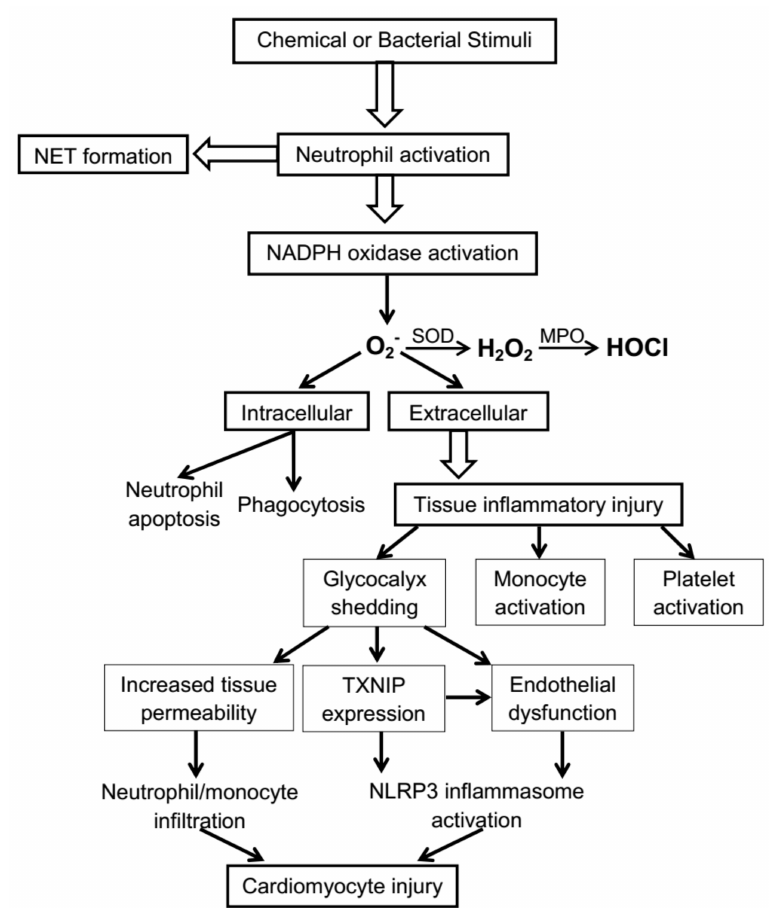
Figure 1. Cascade of intracellular and extracellular consequences of redox stress related to neutrophil activation. SOD = superoxide dismutase; MPO = myeloperoxidase; TXNIP = thioredoxin-interacting protein; NLRP3 = NOD-like receptor family, pyrin domain-containing